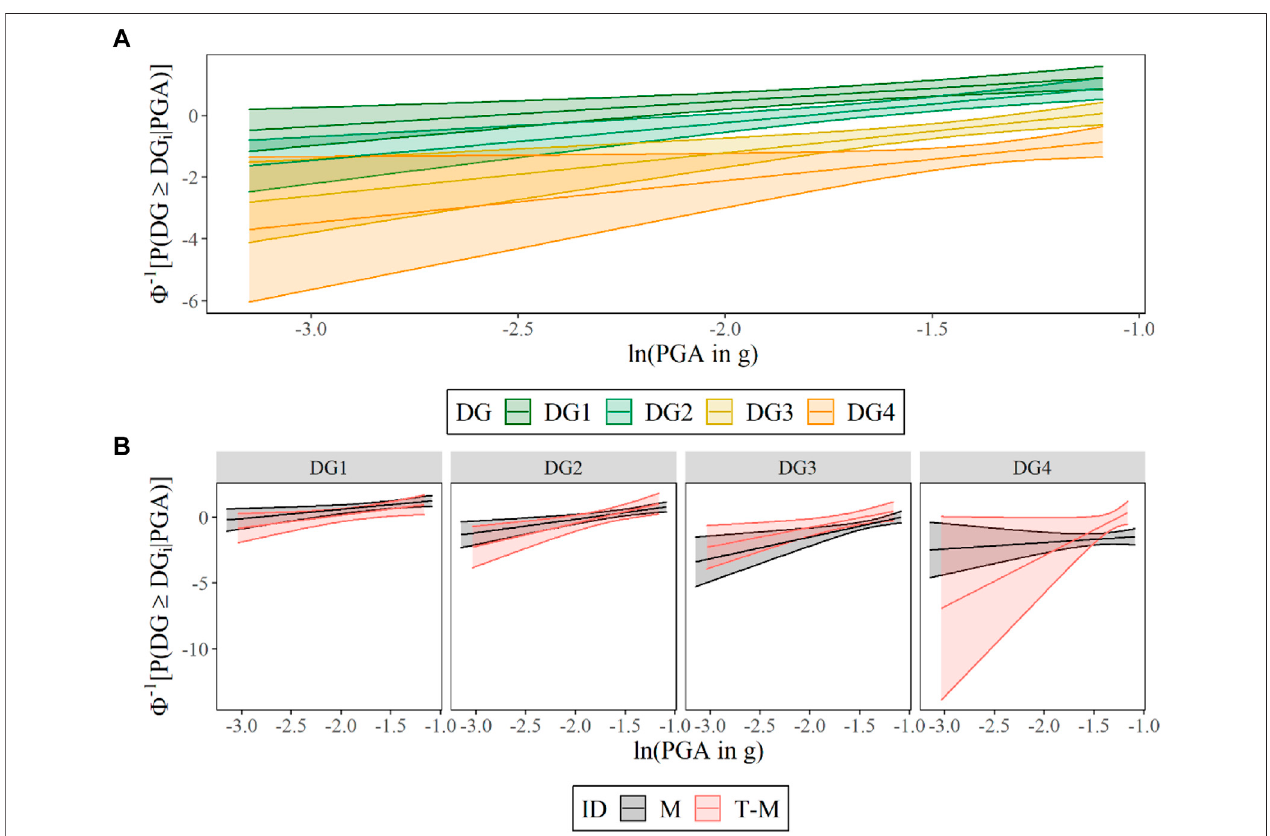
FIGURE10| Best-estimatefragility curves and their90%con fi denceintervals corresponding tofourdamage statesobtainedby fi ttingprobit modelsto (A) alldata in the database irrespective of building typology and (B) subsets of data, i.e., masonry and hybrid timber-masonry buildings to assess the impact of building typology to the slope and intercept of the curves.